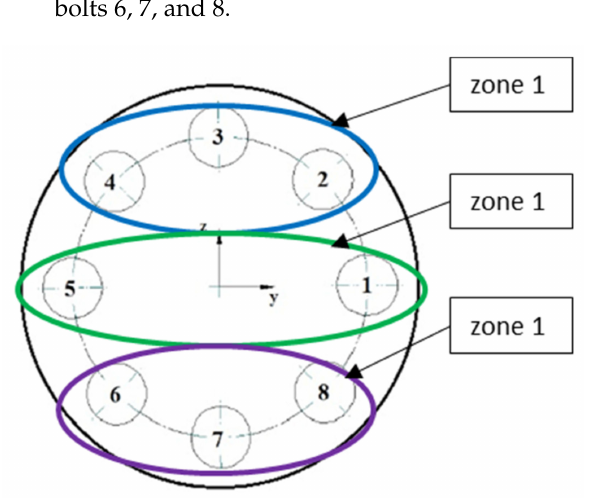
Figure 15. Characteristic bolt-load zones; flange joint subject to static bending (Numbers from 1 to 8 represent the numbers of the